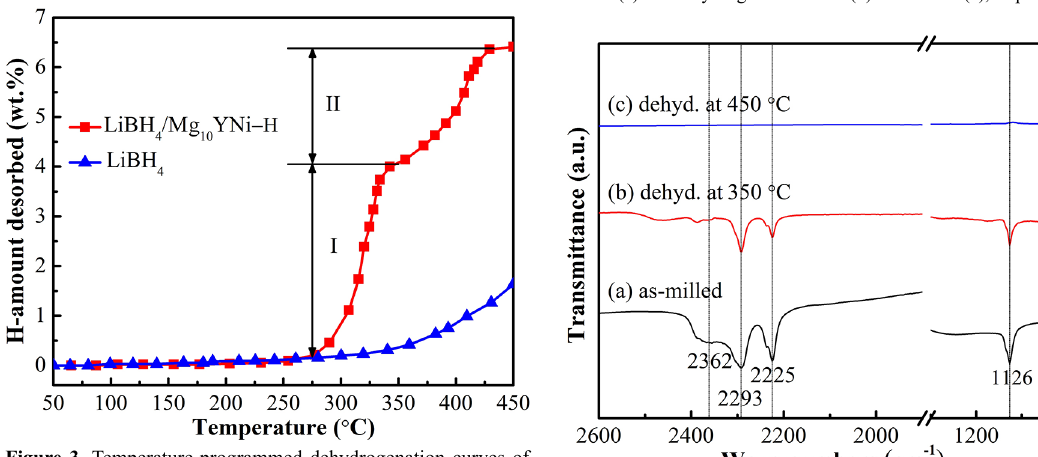
Figure 3. Temperature-programmed dehydrogenation curves of the LiBH /Mg YNi-H composite and pristine LiBH 4 10